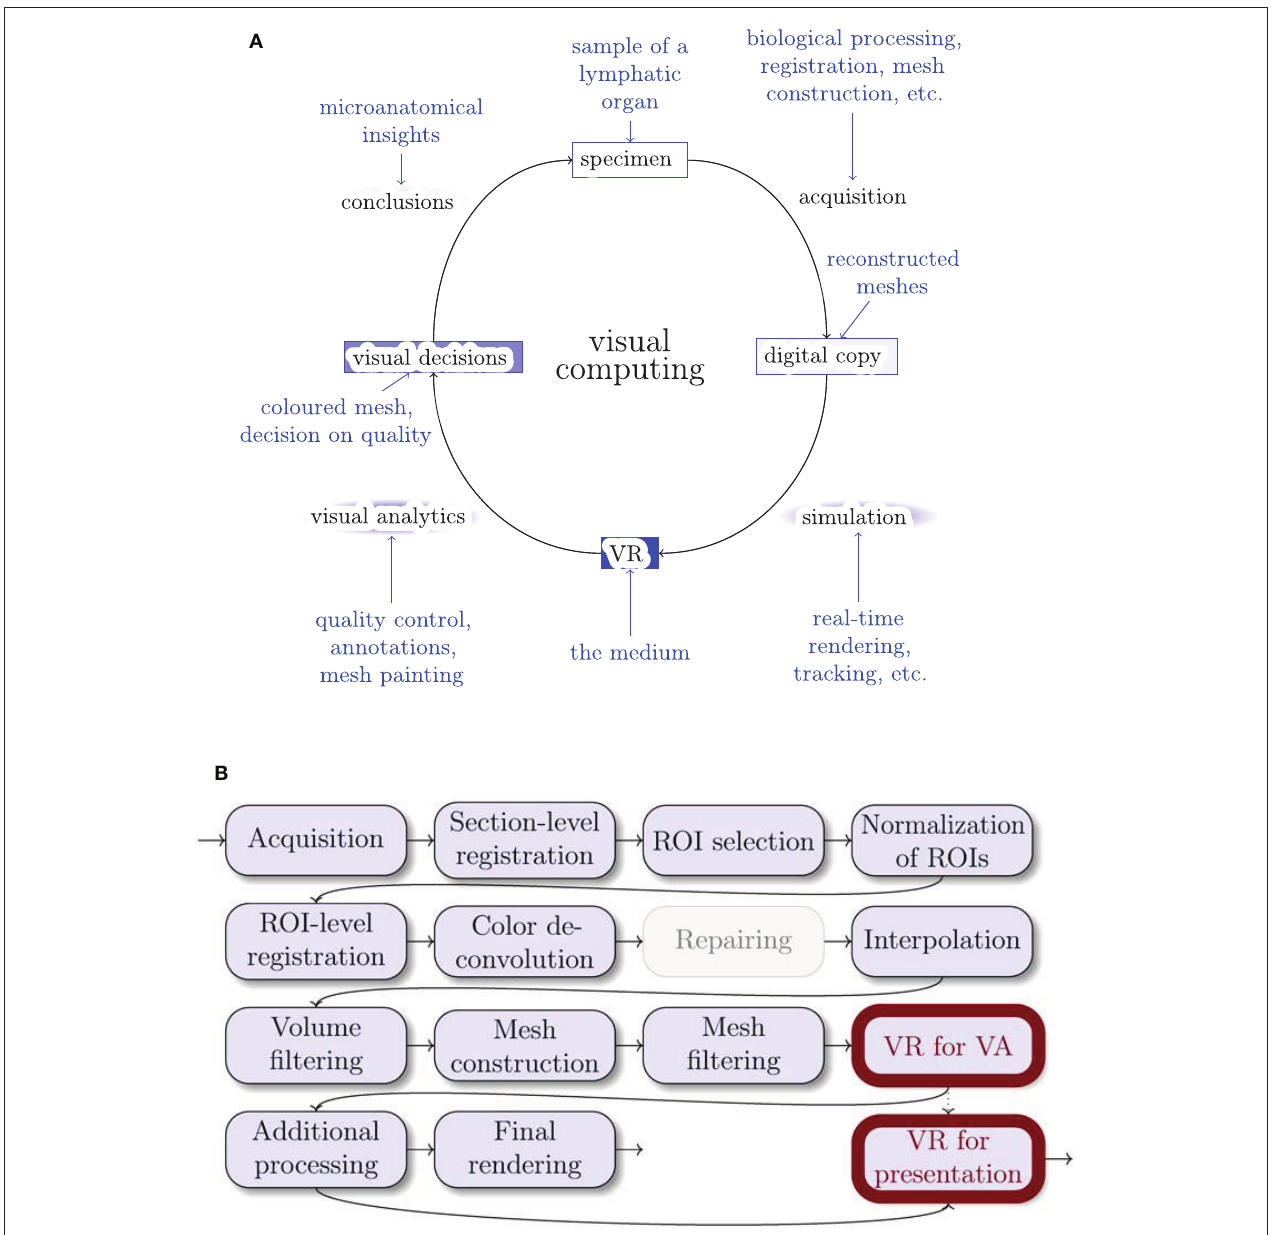
FIGURE 1 | Where do we stand? (A) The general life cycle of visual computing (black) and our specific case (blue). The intensity of blue shading of the blocks highlights their importance for this paper. Blue arrows show facets of our implementation. (B) The outline of our 3D reconstruction pipeline. Gray nodes are not always used. ROI stands for “region of interest,” VA means “visual analytics.” Thick outlines are the major focus of this work.